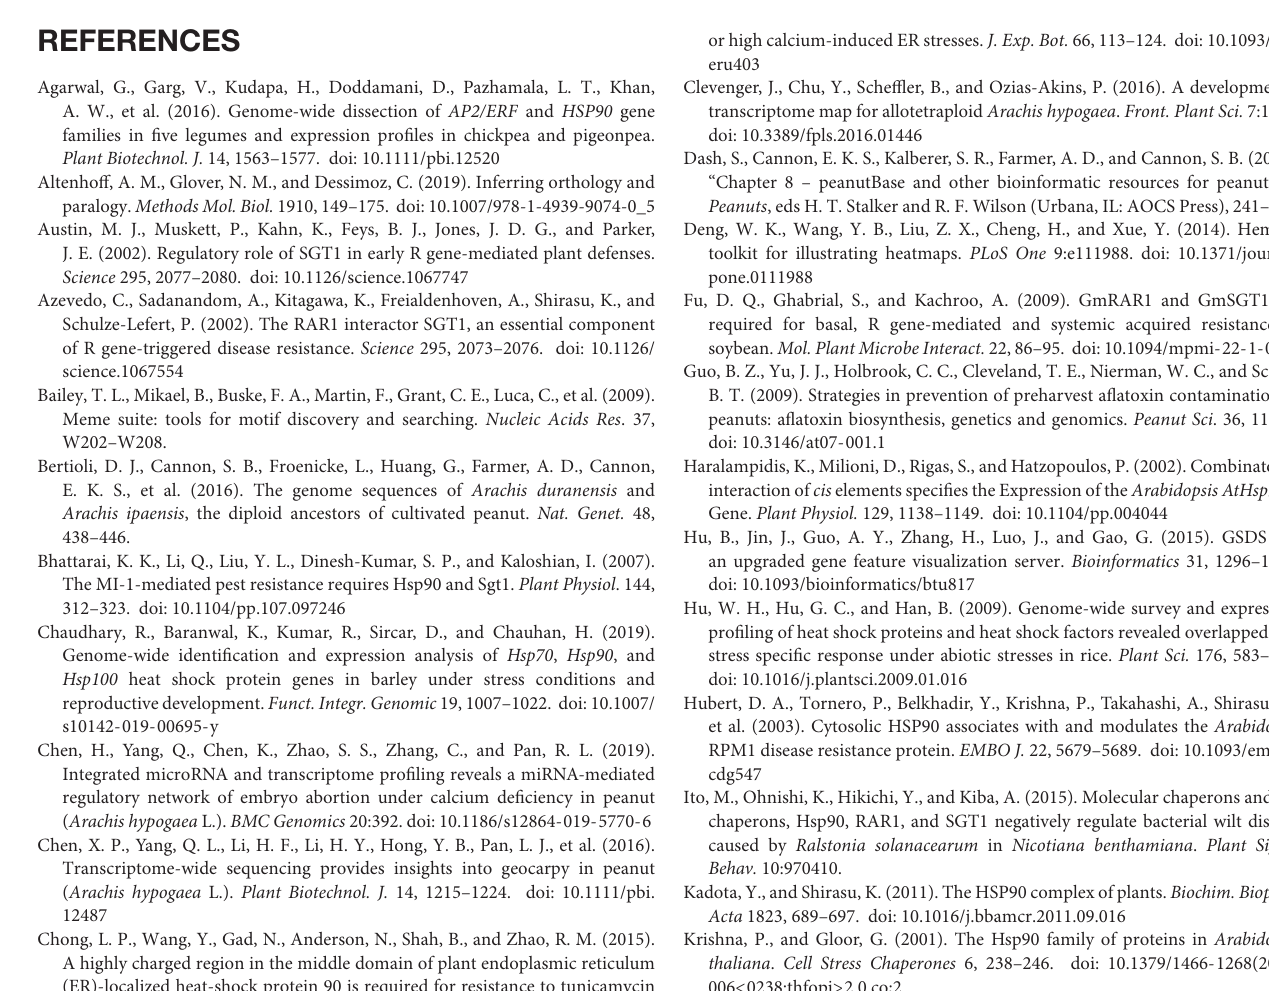
Supplementary Figure 1 | Amino acid comparison between AhRAR1-A and AhRAR1-B. Supplementary Figure 2 | Gene structure of RAR1 from cultivated peanut. (A) Comparison of DNA sequence between AhRAR1-A, AhRAR1-B and AtRAR1. (B) The numbers and nucleotide acid length of exons and introns of AhRAR1-A, AhRAR1-B and AtRAR1. (C) Deduced amino acid sequence of RAR1. Domains CHORD-I (position 9 to 68), CCCH (100 to 118), and CHORD-II (159 to 218) are boxed. Invariant cysteine and histidine residues are indicated in red letters. Supplementary Figure 3 | Amino acid comparison among SGT1-1 genes. Supplementary Figure 4 | Amino acid comparison among SGT1-3